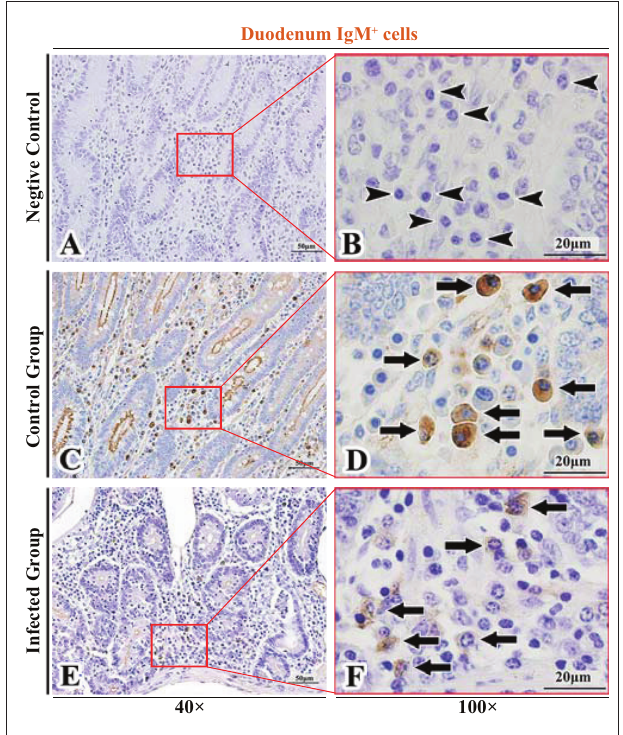
FIGURE 3 | Distribution of IgG + cells in sheep duodenum. (A,B) are negative controls; (C,D) are Control groups; (E,F) are Infected groups. Triangular arrows indicated plasma cells, arrows indicated IgG + cells, and the right image (Scale bar, 20 µ m) is a magnification from the part of the left image (Scale bar, 50 µ m).